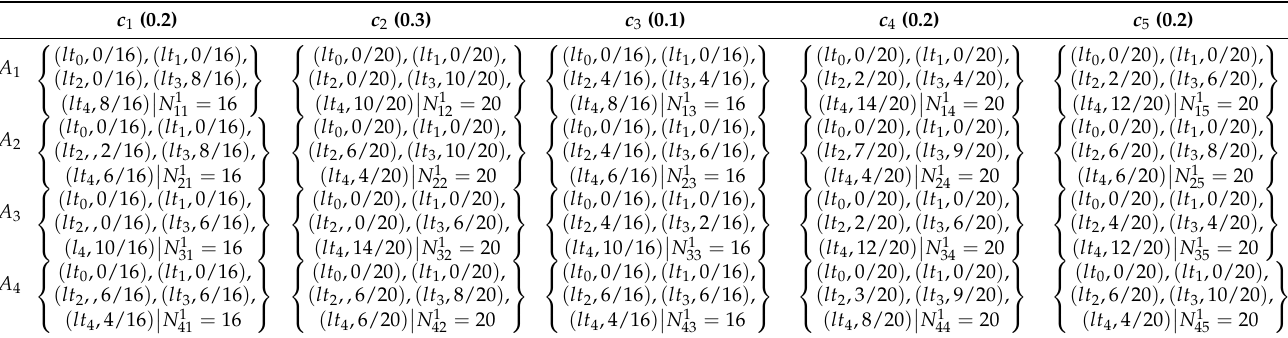
Table 1. LDAs decision matrix of d 1 .